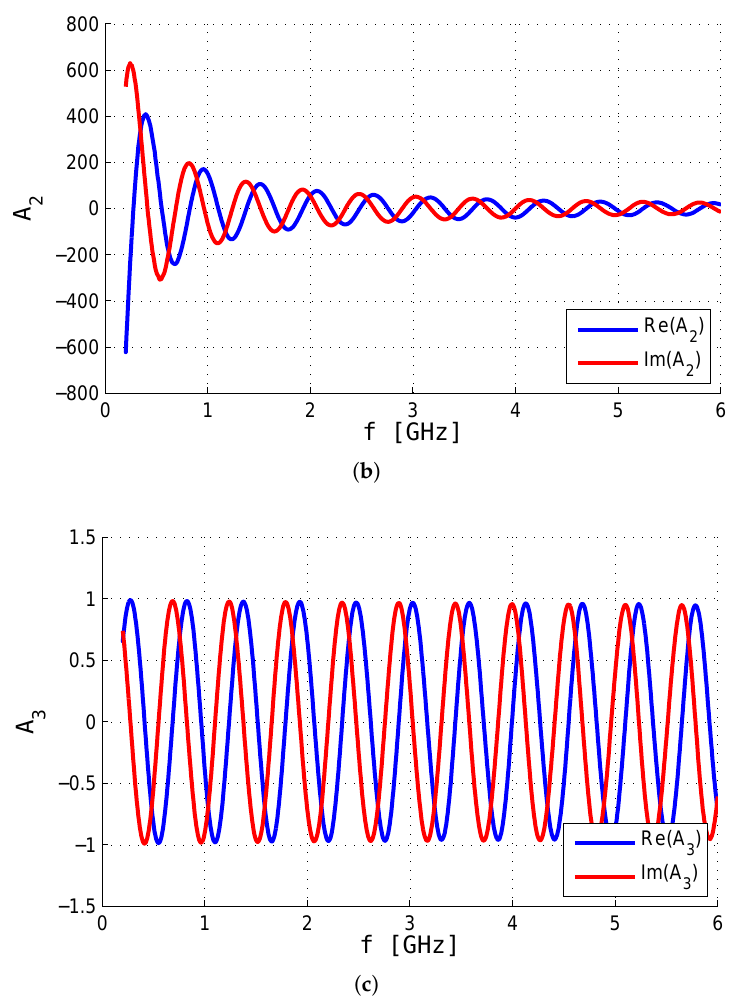
Figure 9. A i coefficients using deionized water as reference. ( a ) A1. ( b ) A2. ( c )